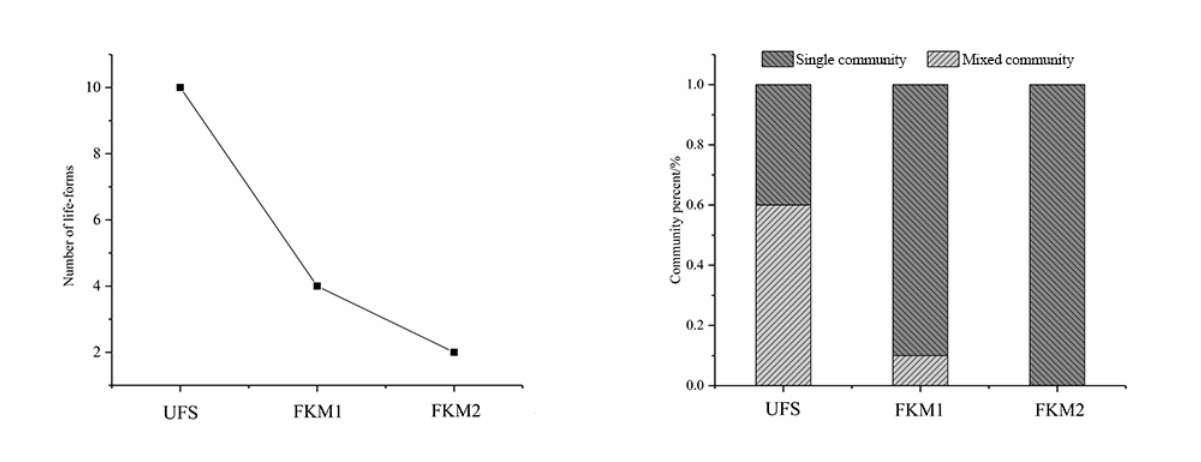
Figure 5 Comparison of bryophyte communities and life forms in the sinkhole forest (UFS) and the two forests (FKM1 and FKM2) on the surface of the